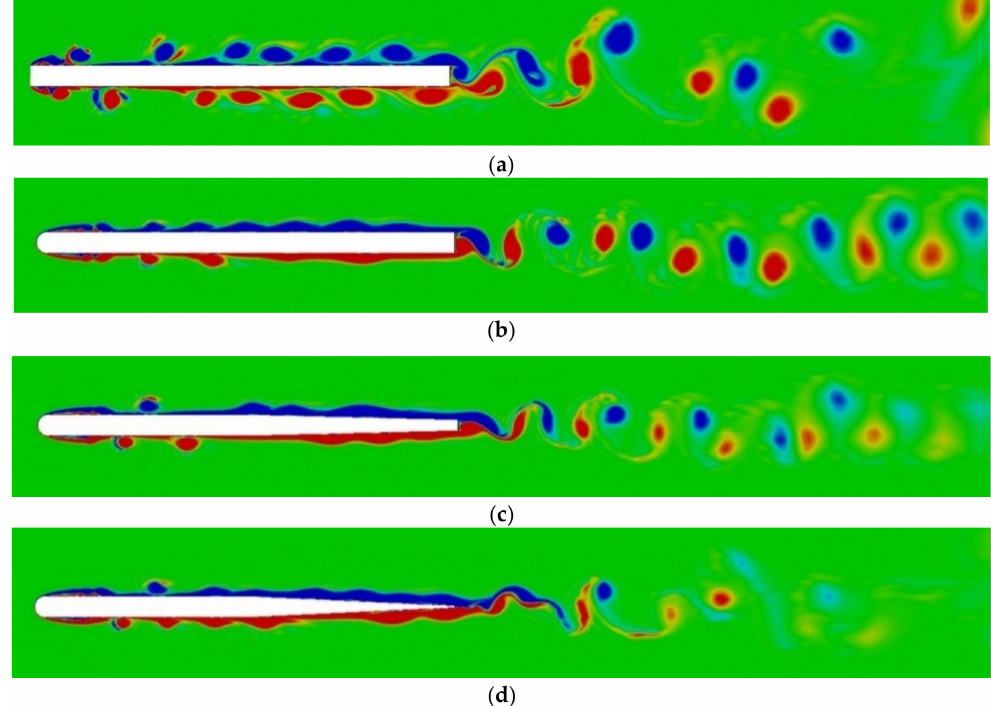
Figure 14. Instantaneous patterns of vorticity field around a uniformly moving horizontal plate at various designs of its leading and trailing edges (rectangular plate with sharp corners ( a ), a rounded leading edge ( b ) and a tapered trailing edge ( c , d )), T b = 5.25 s, N = 1.2 s − 1 , L = 10 cm, U = 80 cm/s, α = 0 ◦ , red and blue colors in the color spectrum correspond to positive and negative values of the vorticity field within the range, − 100 < ω < 100 s − 1 , and green color corresponds to zero value of